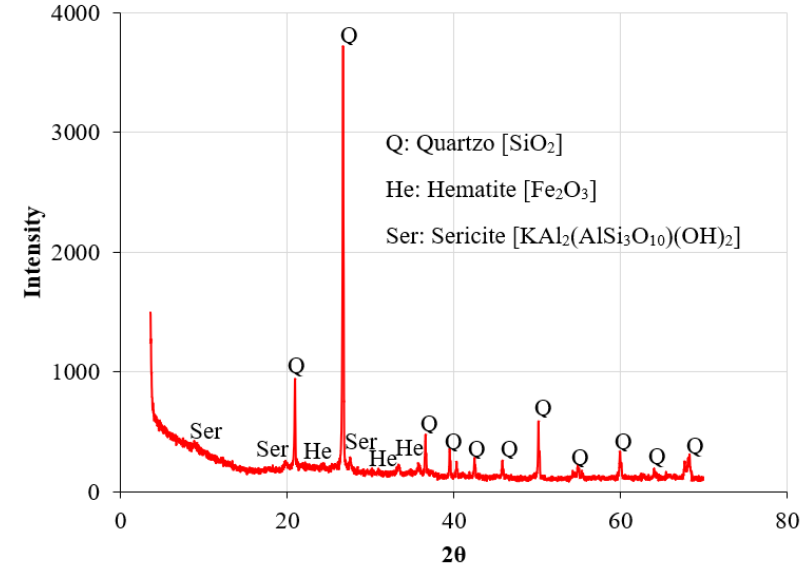
Figure 2. X-Ray diffractometry of a roof tile waste sample. Table 1. Geotechnical properties of the silts and some observations of the collection.